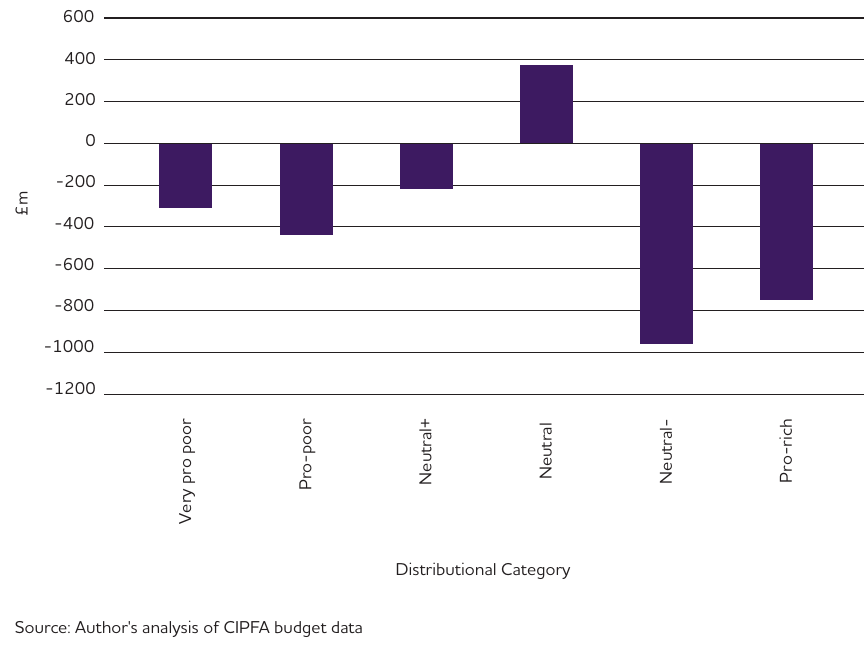
Figure 19: Real Budget change by English Local Authorities by Distributional Character of Service (£million, excluding